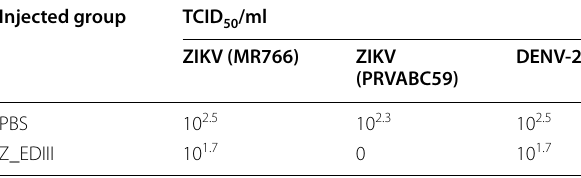
Table 2 Assessment of viremia in neonatal mice serum Injected